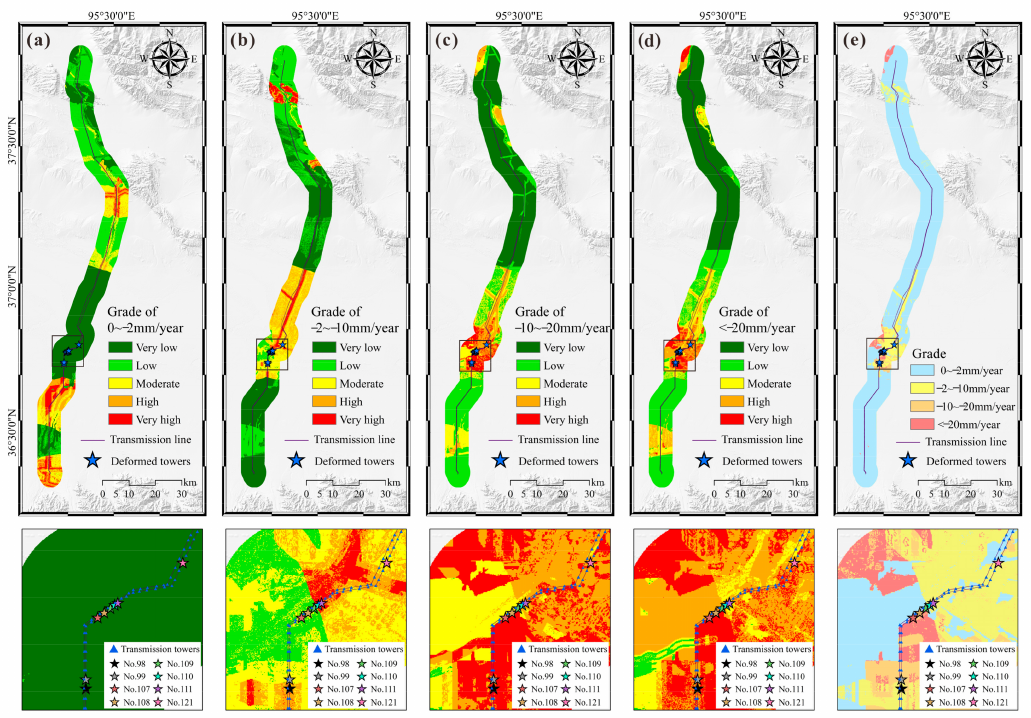
Figure 9. The land subsidence susceptibility maps at different land subsidence intensities: ( a ) grade of 0~ − 2 mm/year; ( b ) grade of − 2~ − 10 mm/year; ( c ) grade of − 10~ − 20 mm/year; ( d ) grade of < − 20 mm/year; ( e ) susceptibility result of different land subsidence intensities grades.